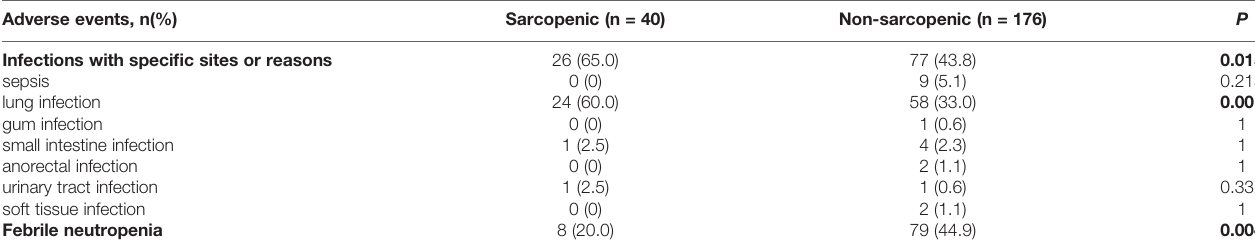
Bold values mean the P values were <0.05 and of statistical signi fi cance.